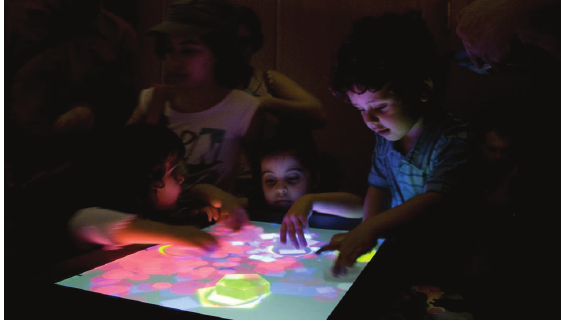
Figure 5 : Untitled* at Serralves on 30th July 09